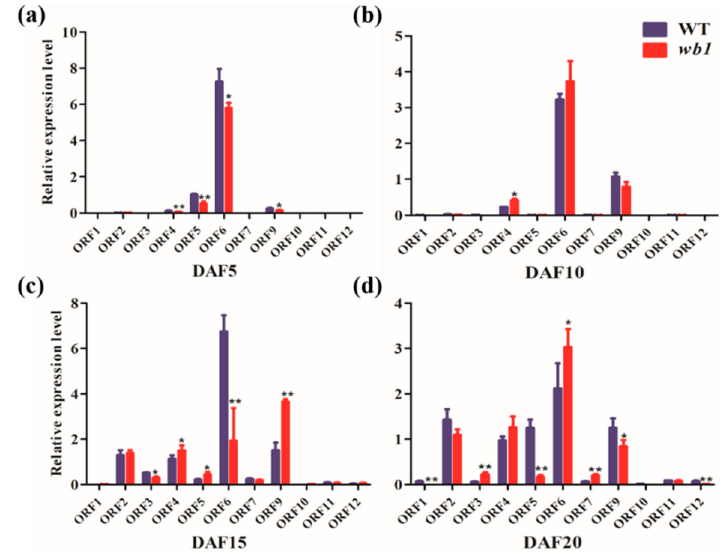
Figure 4. Relative expression analysis of 11 candidate genes based on real-time quantitative PCR (qPCR) at four stages of endosperm development between WT and wb1 . ( a ) Relative expression analysis of 11 candidate genes at DAF5 stage; ( b ) Relative expression analysis of 11 candidate genes at DAF10 stage; ( c ) Relative expression analysis of 11 candidate genes at DAF15 stage; ( d ) Relative expression analysis of 11 candidate genes at DAF20 stage. All data were compared with transcript levels of WT by Student’s t -test (* p ≤ 0.05, ** p ≤ 0.01). Values were means ± SD ( n = 3).